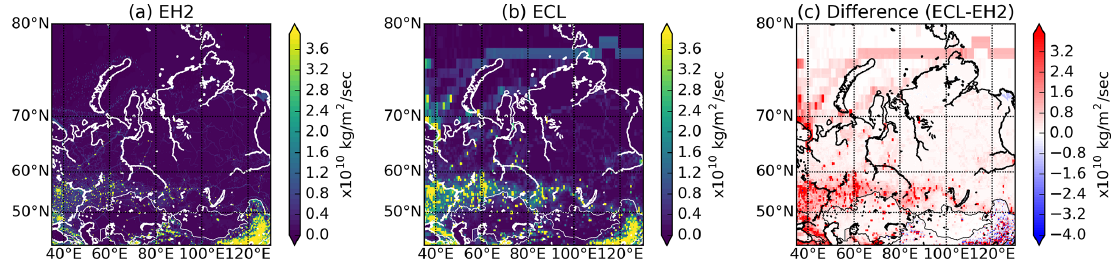
Figure 2. Spatial distribution of anthropogenic emissions according to EDGAR-HTAP v2.2 (a) and ECLIPSE v5a (b) inventories. Difference between the two inventories is shown in panel (c) (ECLIPSE v5a − EDGAR-HTAP v2.2). Table 1. Total NO x emissions (kilotons per month) for the study domain from EH2 and ECL anthropogenic emission inventories, and soil NO x contribution from GEIA. Contributions from energy and transport sectors shown for each inventory. EH2 EH2 EH2 ECL ECL ECL GEIA soil total energy transport total energy transport NO x May 915.5 306.0 375.2 989.8 324.4 481.7 51.4 June 911.3 307.8 374.1 985.3 326.3 480.3 71.9 July 870.4 297.1 367.8 941.1 315.0 472.2 84.1 August 864.4 294.0 368.7 934.6 311.7 473.3 88.9 Total 3561.6 1204.9 1485.8 3850.8 1277.4 1907.5